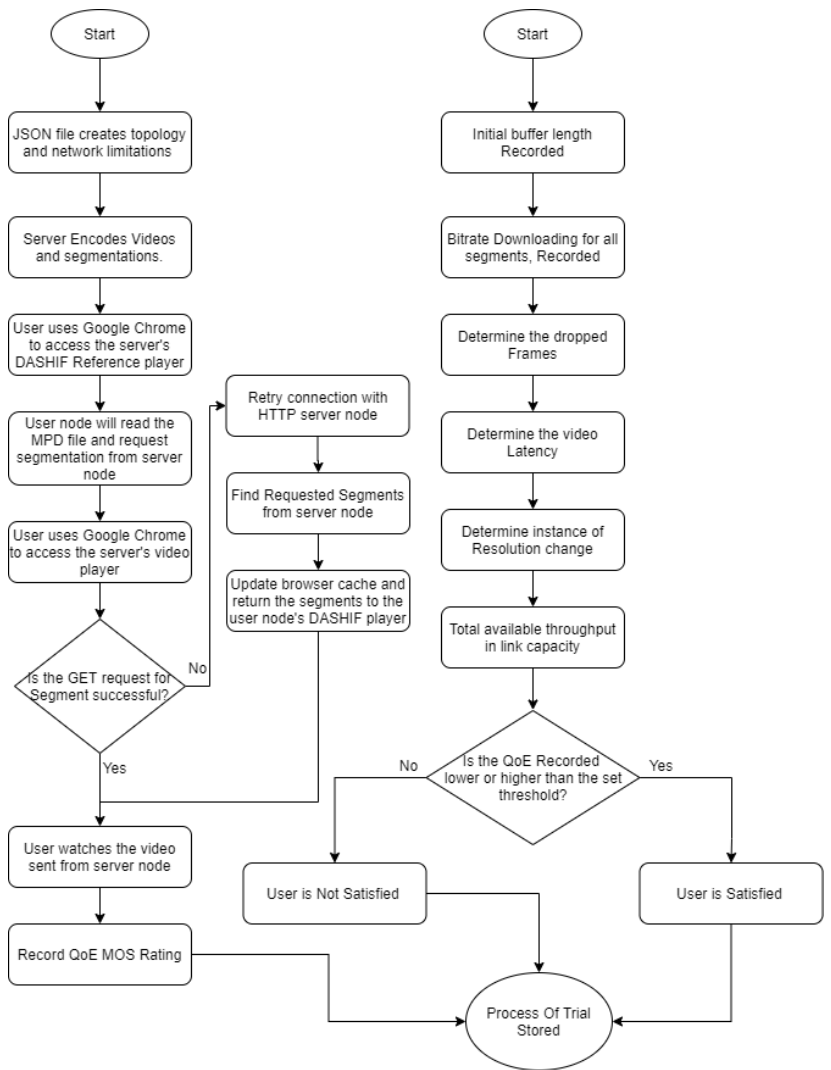
Figure 3. System test bed process and QoE